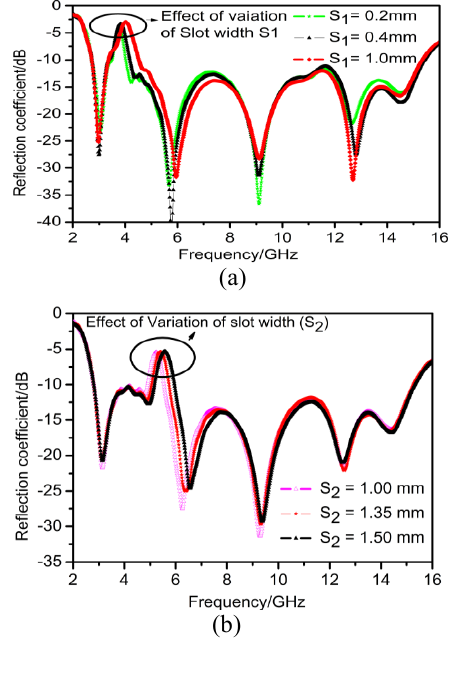
Figure 3: Design of CPW fed UWB antennas with slot 1, 2